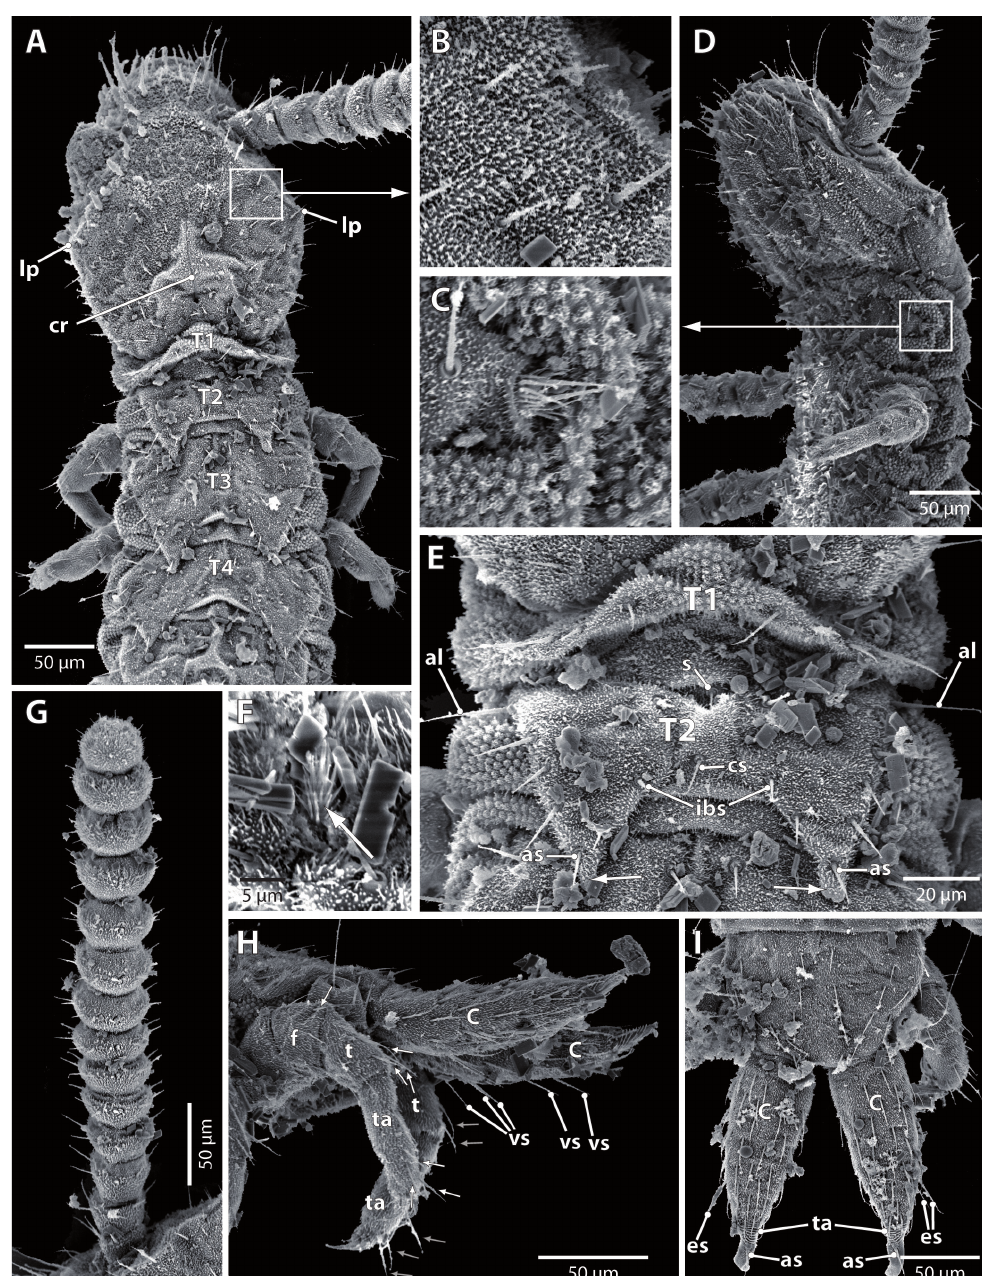
Fig. 4. Symphylella lubumbashi sp. nov., holotype (dorsal views) and paratype (ventral and lateral views). A . Head and first 4 tergites ( T1, T2, T3, T4 ), dorsal view. Cr , central rod; lp , lateral protuberances of the head. B . Detail of the surface of the head. C . Detail of the first leg. D . Head and first 2 pairs of legs, ventro-lateral view. E . Detail of first ( T1 ) and second ( T2 ) tergites. Arrows , small end-swelling of triangular processes; al , anterolateral setae; as , apical setae; cs , central seta of the posteromarginal setae; ibs , inner basal setae of the posteromarginal setae; s , seta between first and second tergites. F . Right antenna. G . Stylus of the leg 11 ( arrow ). H . Posterior part of the trunk, last pair of legs and cerci ( C ), lateral view. White arrows , protruding setae of the femur ( f ), tibia ( t ) and tarsus ( ta ) of last left leg; grey arrows , protruding setae of tibia ( t ) and tarsus ( ta ) of the right left; vs , ventral setae of right cercus, in a row. I . Last tergite and cerci ( C ), dorsal view. As , apical setae; es , erect setae of outer side of cerci, ta , terminal